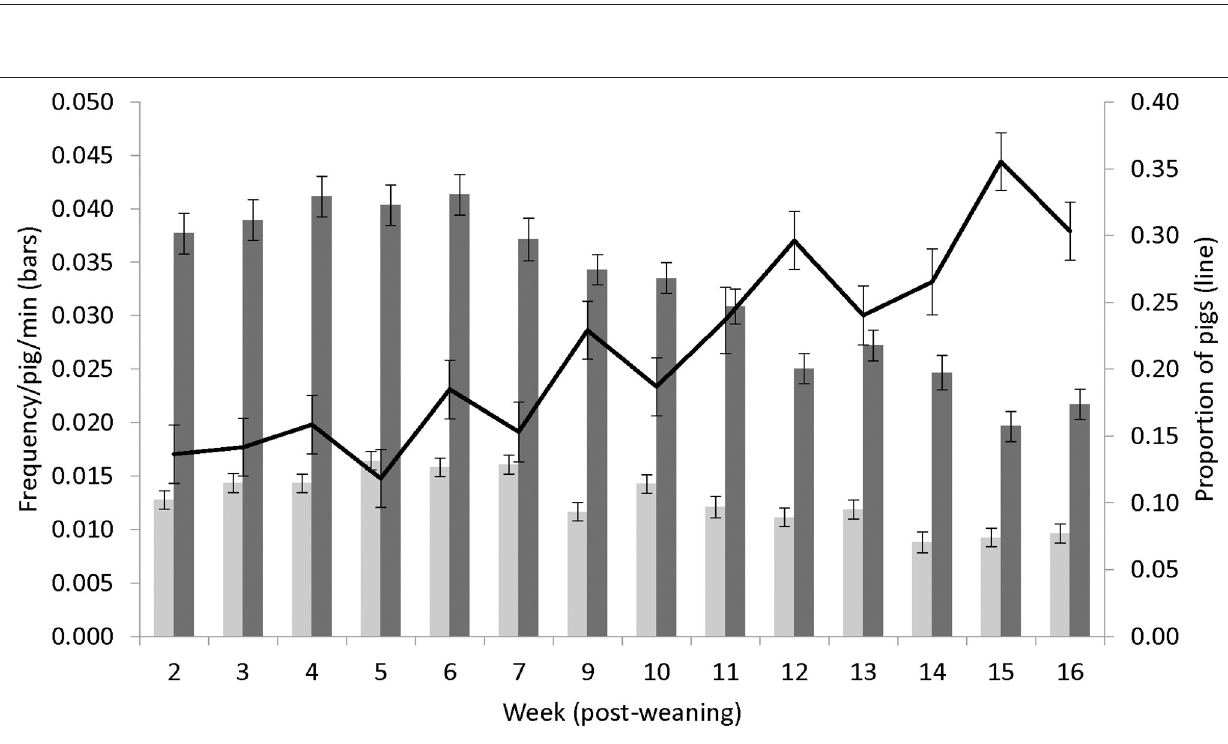
Frontiers in Veterinary Science |